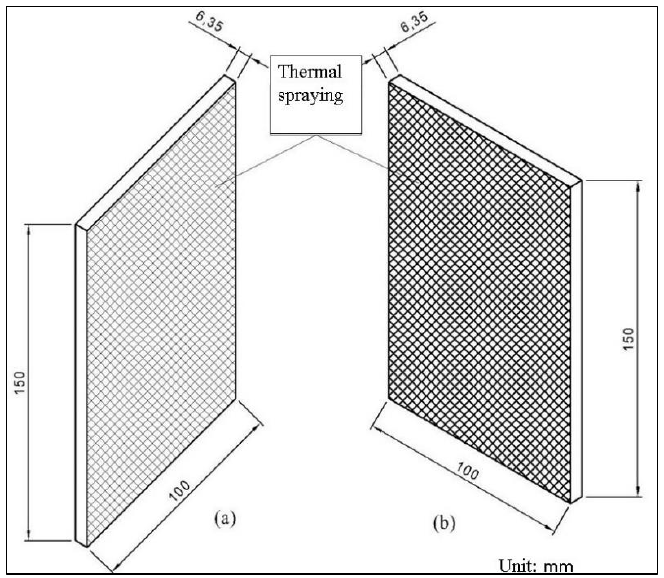
Figure 2: Dimensions and surface characteristics of samples: (a) sample without sealant, (b) sample with sealant Source: Authors, (2022).